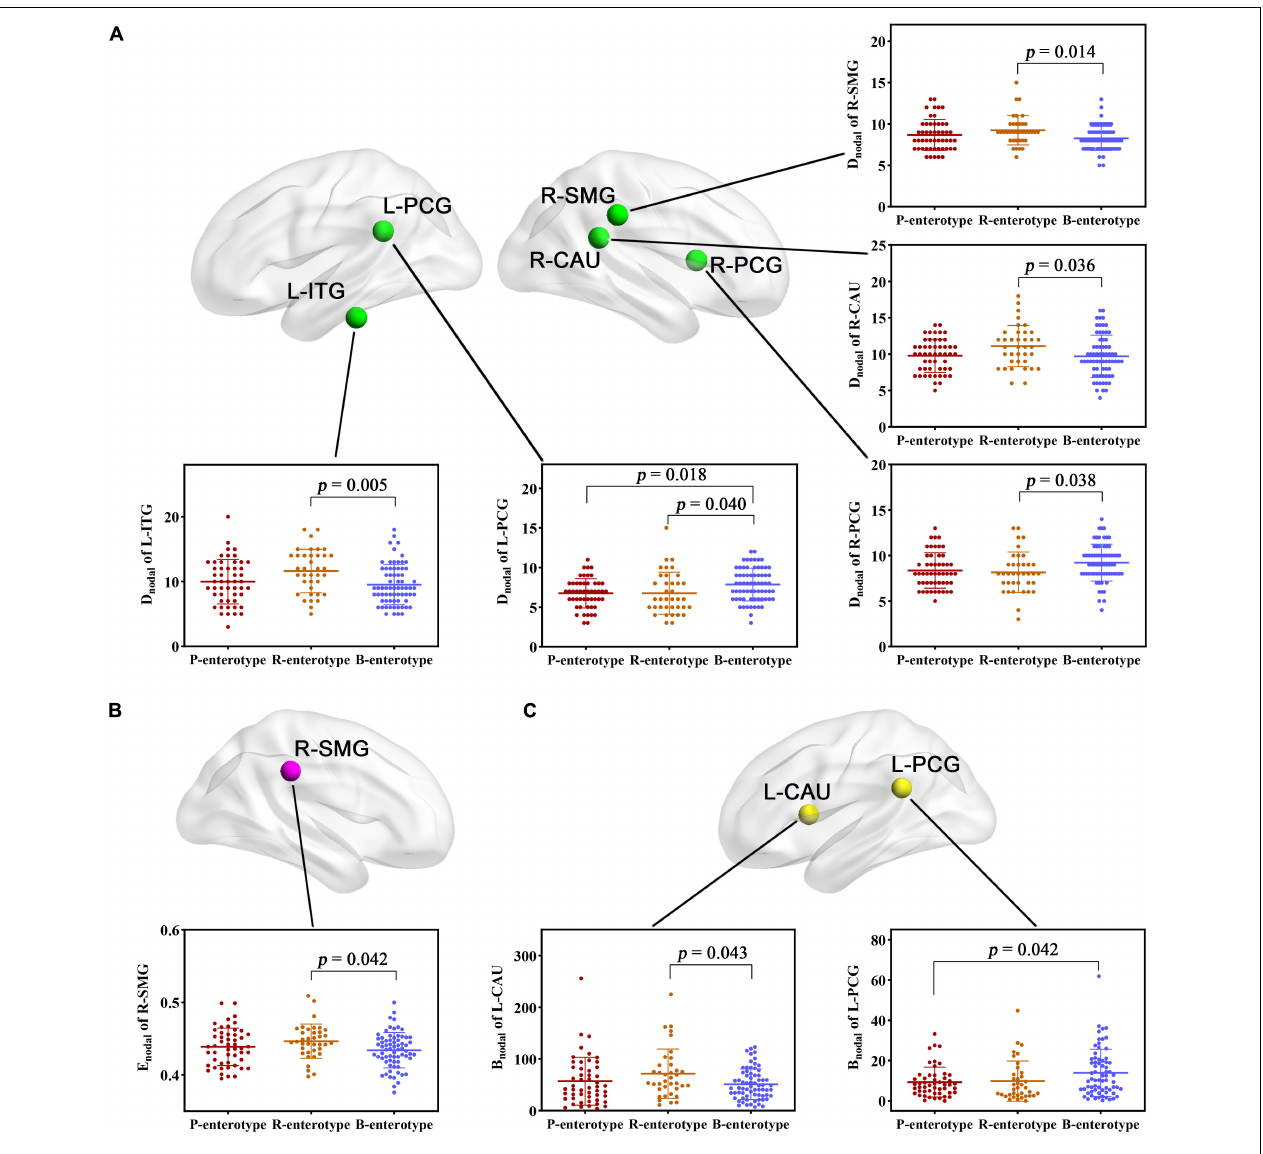
FIGURE 3 | (A–C) Inter-group comparisons in regional topological metrics of SC across enterotypes. Spatial maps show the significantly different nodes (i.e., brain regions). B nodal , nodal betweenness; CAU, right caudate nucleus; D nodal , nodal degree centrality; E nodal , nodal efficiency; ITG, inferior temporal gyrus; L, left; PCG, posterior cingulate gyrus; R, right; SMG, supramarginal gyrus; SC, structural